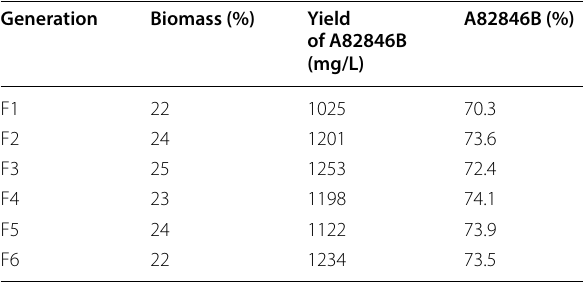
Table 3 Comparison recombinant F1–F6 strains of SIPI- 3927-C6 in shake-flask